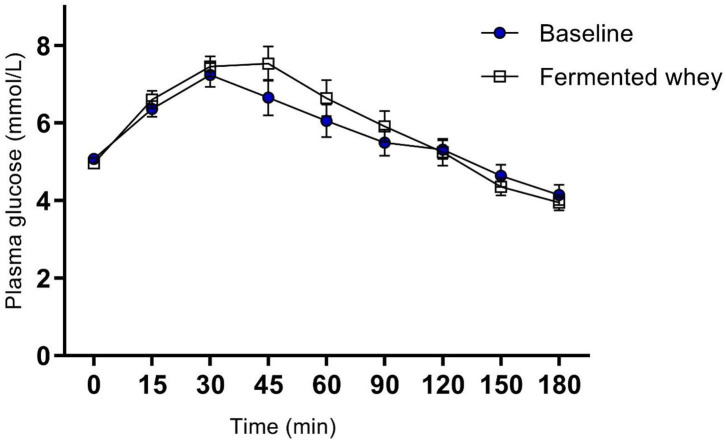
Oral Glucose tolerance test showing group plasma glucose profile in response to a 75 g bolus of glucose, at commencement of study (Baseline) and after 6-weeks of chronic fermented whey consumption (Fermented whey, n = 17).